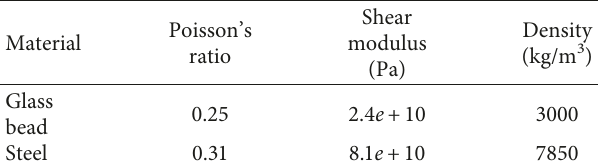
Table 1: Material parameters used in the